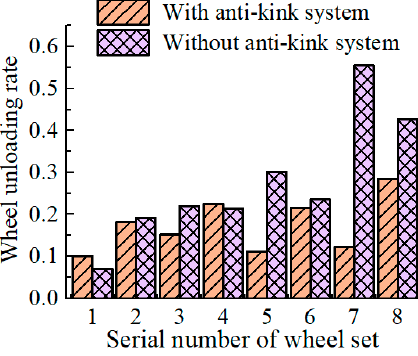
Figure 18. Wheel unloading rate.